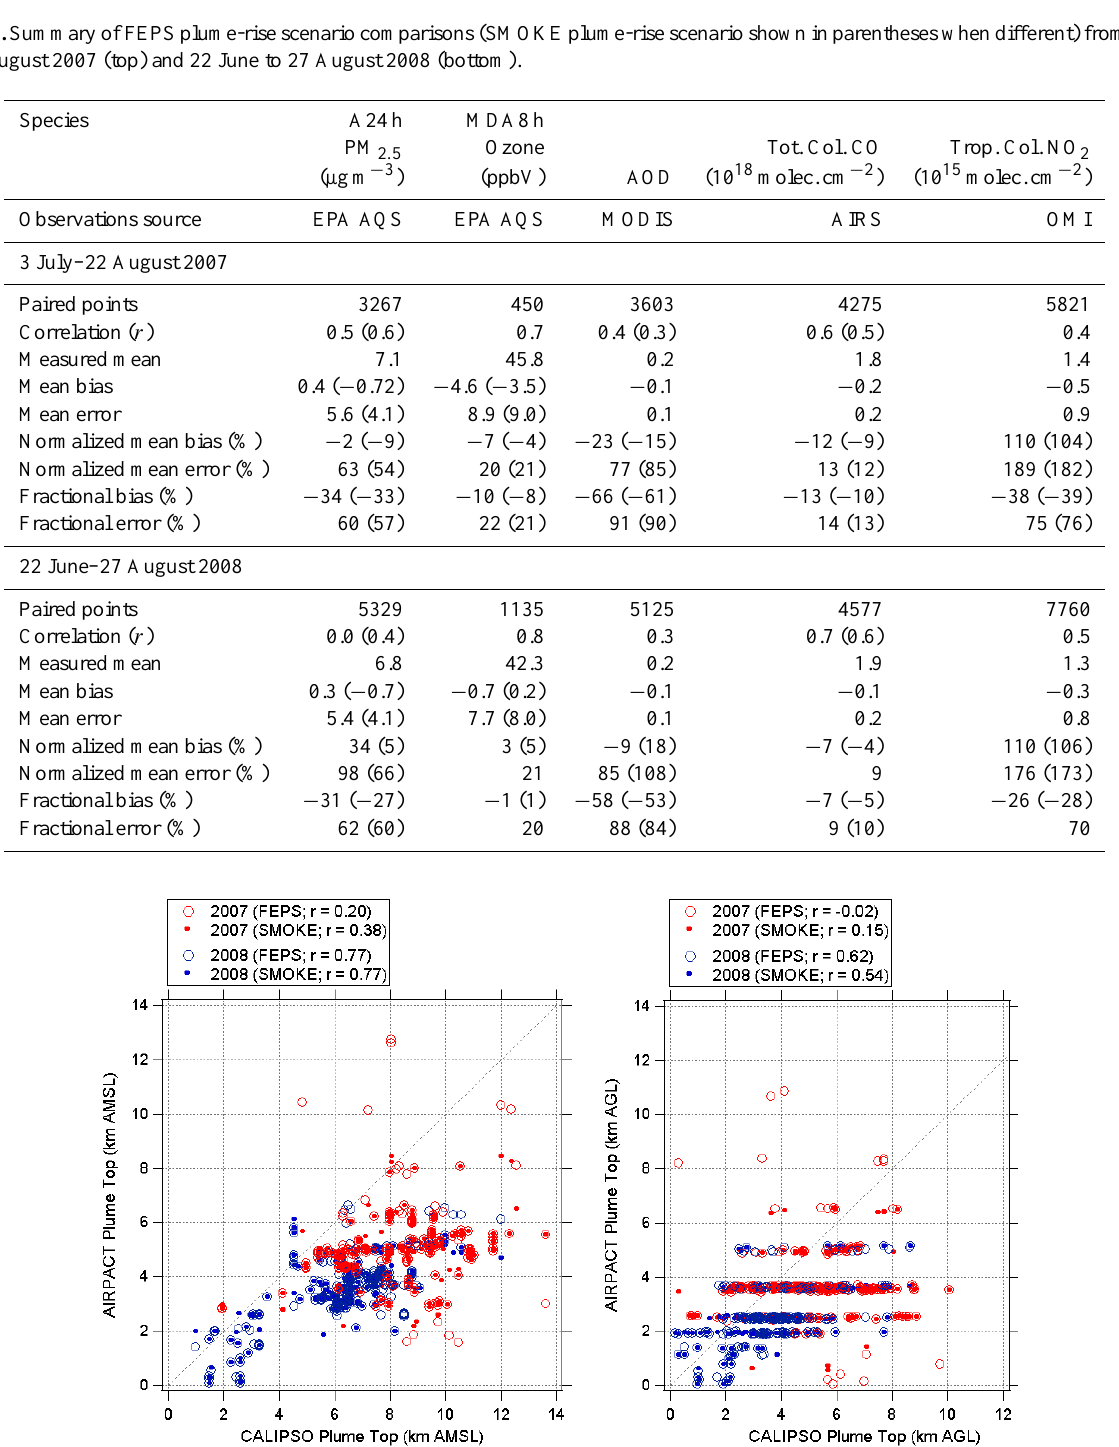
Figure 7. AIRPACT-3 vs. CALIOP plume top heights for 2007 (red) and 2008 (blue) when CALIPSO passed over the Idaho and California wildfires, respectively ( ∼ 2 p.m. LST). Plume top heights above sea level (left) and above ground level (right) are shown for both the FEPS plume rise (open circle) and SMOKE plume-rise (solid dot) scenarios. Note that plume top heights are only shown for locations where both CALIOP and AIRPACT-3 showed an aerosol